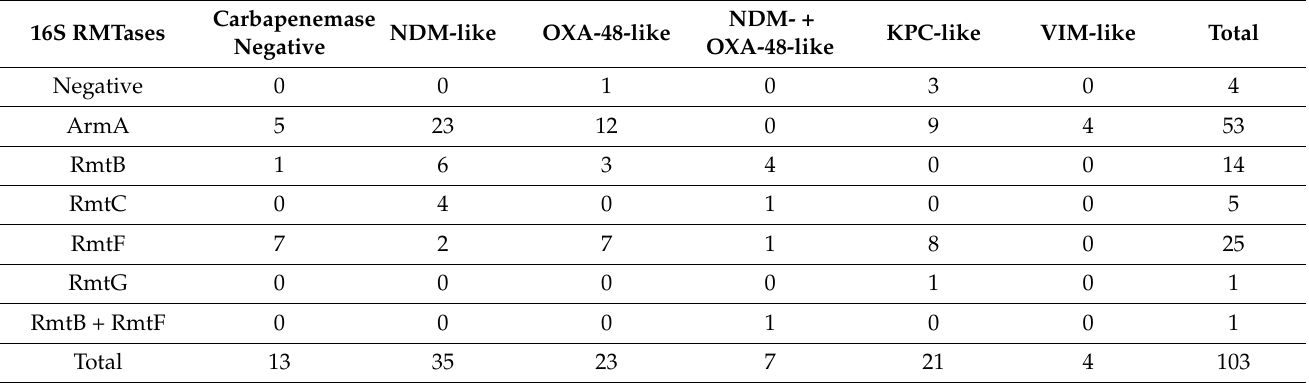
Table 2. Total number of carbapenemase and 16S RMTases detected in pan-aminoglycoside and carbapenem-resistant Enterobacteriaceae between 2017 and 2020 from the